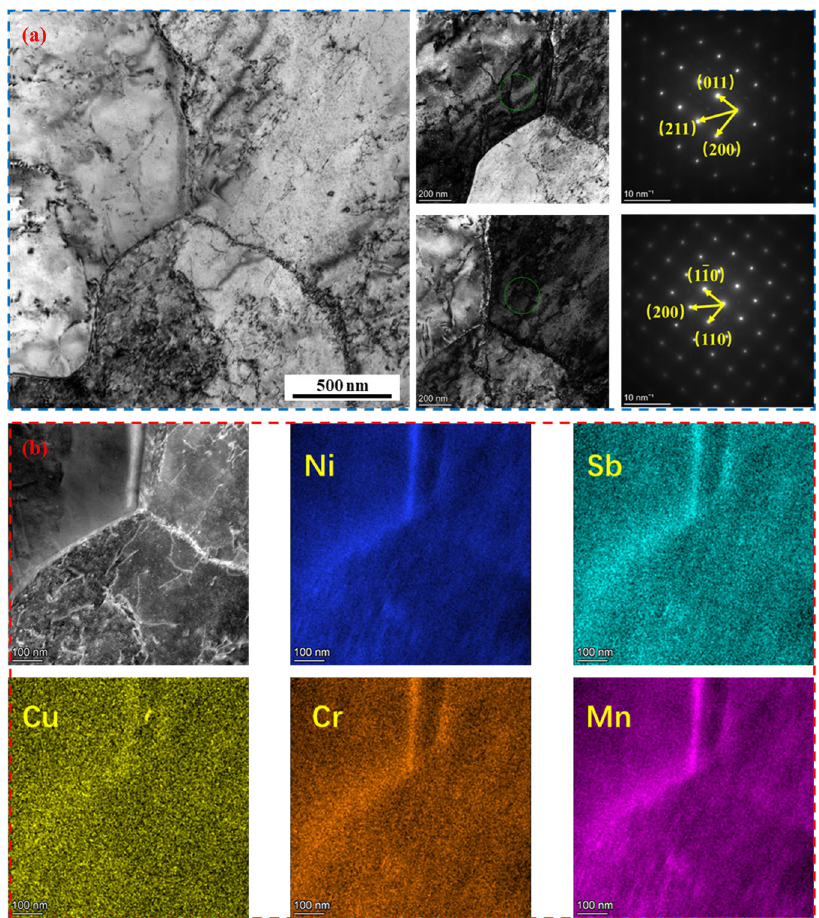
Fig. 2 Segregation of corrosion-resistant elements at grain boundaries. a SAED analysis of adjacent grains in the grain boundary. b EDS analysis of the grain boundary with corrosion-resistant